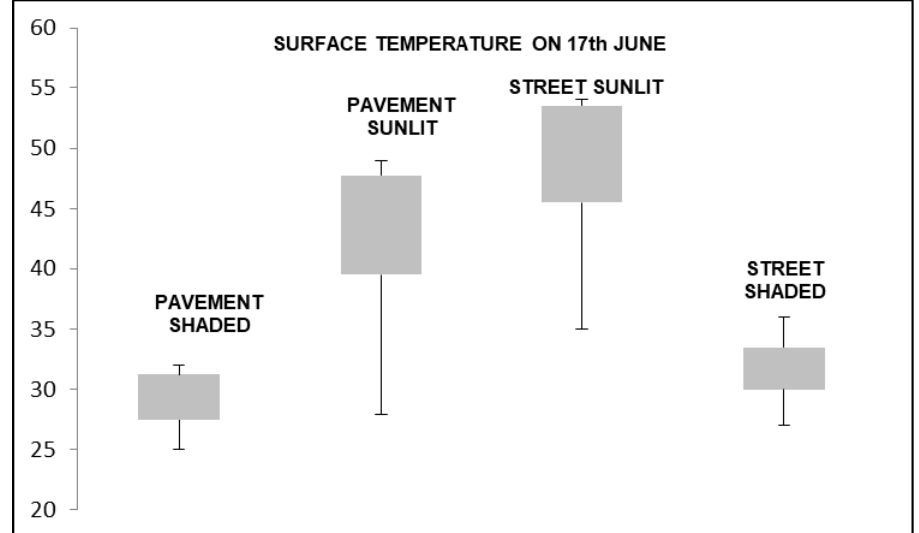
Figure 8. Surface temperature measured on sunlit and shaded pavement/asphalt/on the 17th of June.